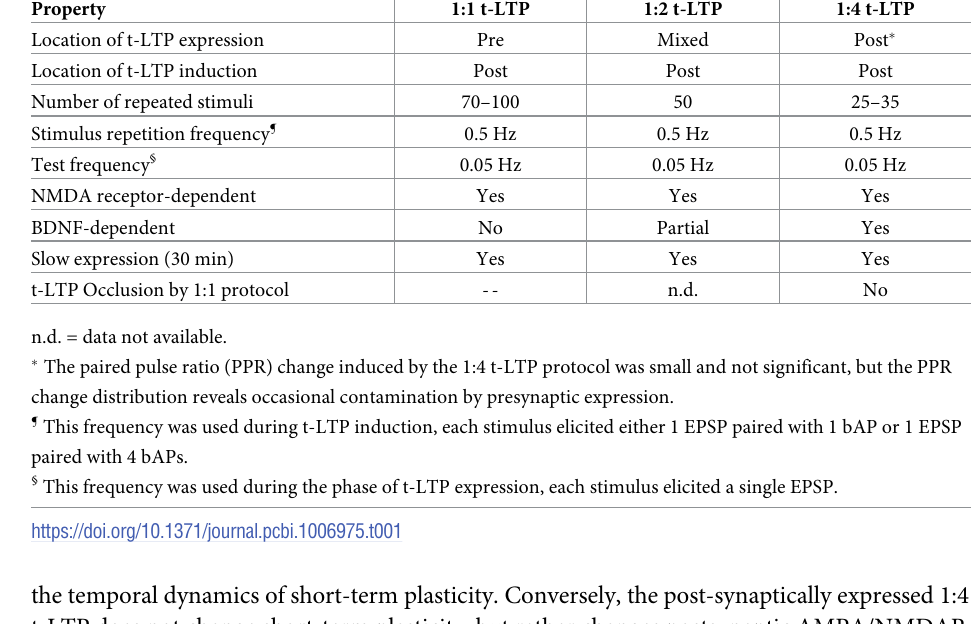
Table 1. Summary of experimental results taken from Edelmann et al.[11]. Property 1:1 t-LTP 1:2 t-LTP 1:4 t-LTP Location of t-LTP expression Pre Mixed Post � Location of t-LTP induction Post Post Post Number of repeated stimuli 70–100 50 25–35 Stimulus repetition frequency ¶ 0.5 Hz 0.5 Hz 0.5 Hz Test frequency § 0.05 Hz 0.05 Hz 0.05 Hz NMDA receptor-dependent Yes Yes Yes BDNF-dependent No Partial Yes Slow expression (30 min) Yes Yes Yes t-LTP Occlusion by 1:1 protocol -- n.d.